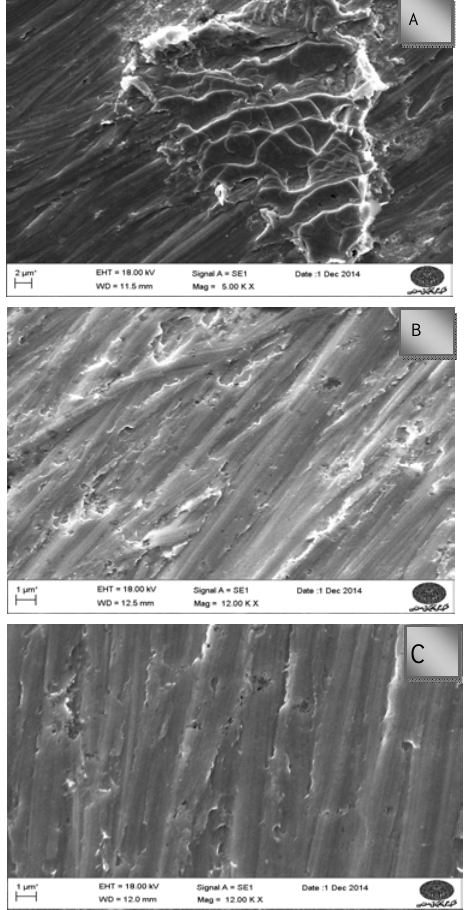
Fig. 7. Scanning electron micrographs for Ni-Co/Cu multilayer samples; A) Ni-Co(5nm)/Cu(2nm), B) Ni- Co(4nm)/Cu(2nm), C)